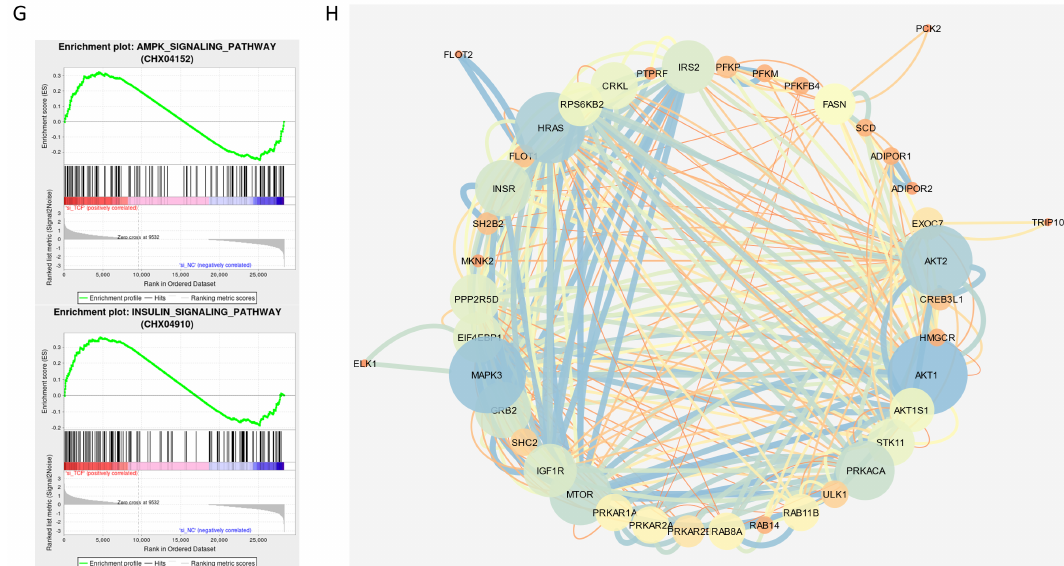
Figure 5. Signaling pathways involved in circTCF4-related differentiation of MuSCs. ( A ) CircTCF4 expression after circTCF4 interference. ( B ) Heat map of correlation between samples. ( C ) Volcano map of differentially expressed genes. ( D ) Heat map of differentially expressed genes. ( E ) GO enrichment of down-regulated mRNA host genes. ( F ) KEGG signaling pathway of up-regulated mRNA host genes. ( G ) Gene set enrichment analysis of differentially expressed genes. ( H ) Protein- protein interaction networks of differentially expressed genes involved in the MuSCs differentiation. Data are means ± standard error from at least three biological replicates, * p <